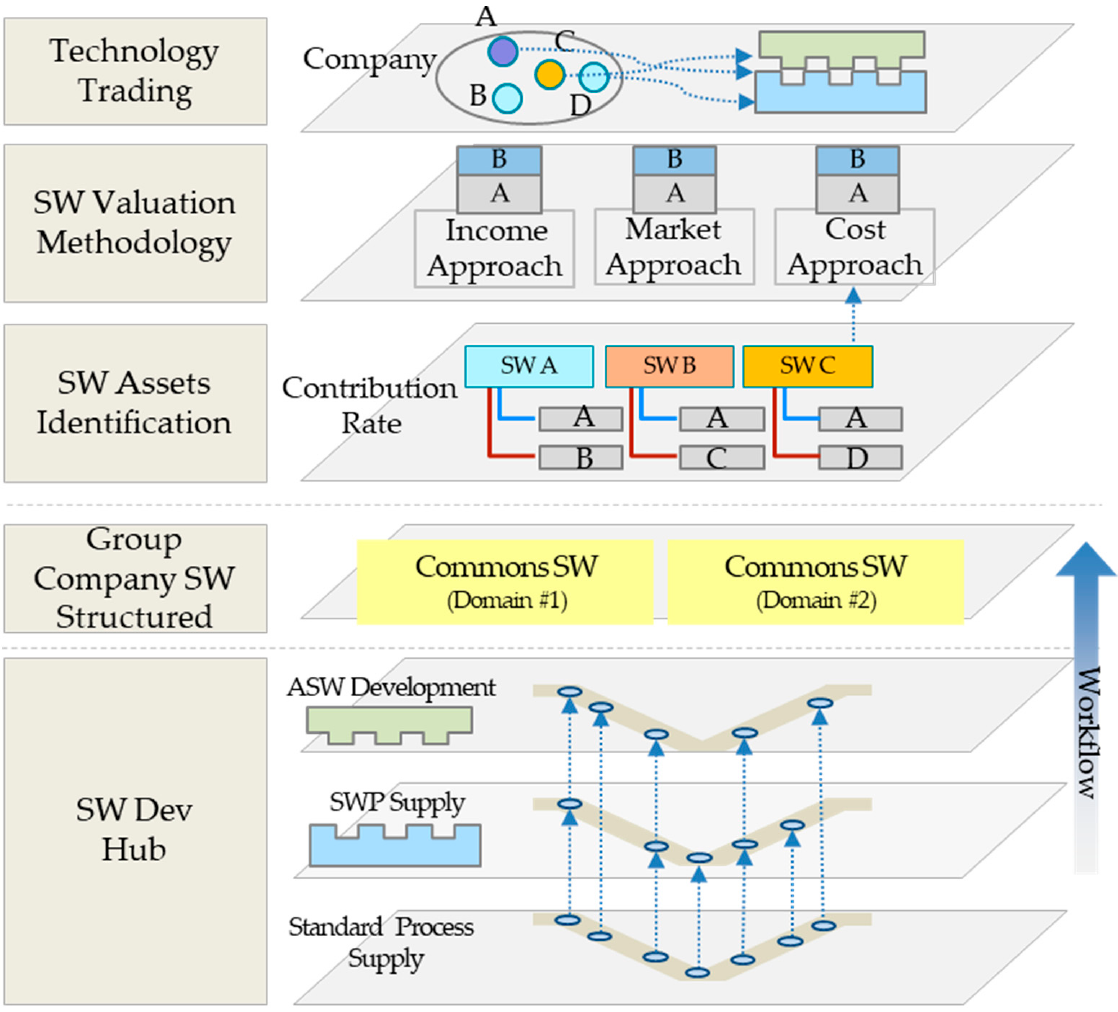
Figure 6. Software co-development concept.